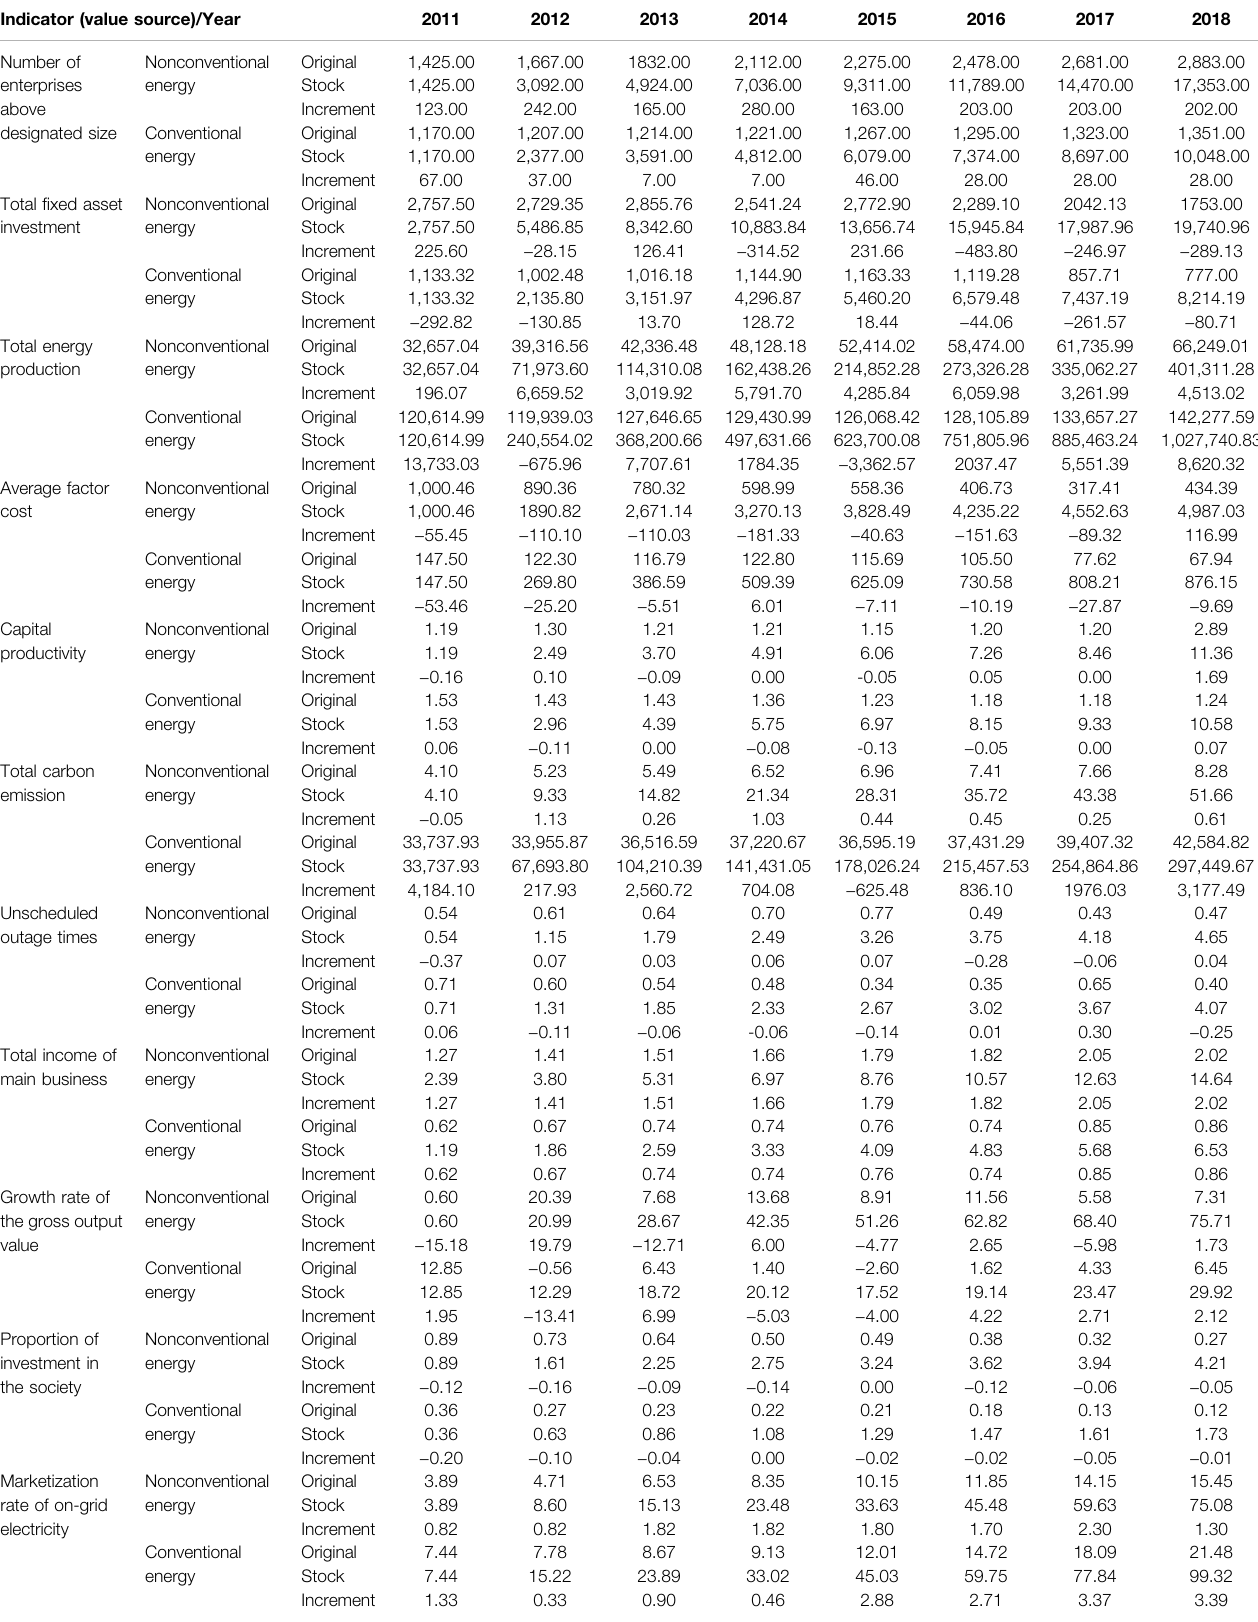
TABLE 3 | Original data and stock-increment dataset of evaluating